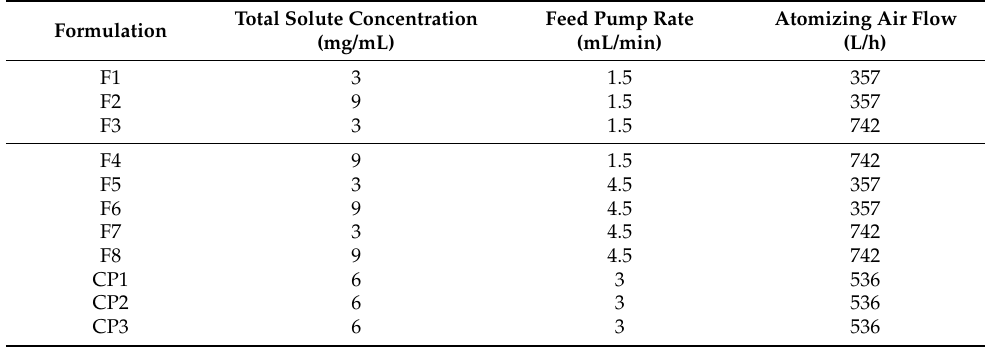
Table 2. Overview of the combinations of the material attribute and process parameters